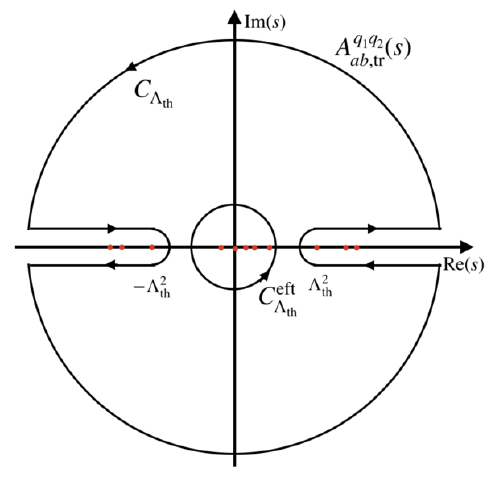
Figure 3 . Tree level dispersion relation contour in the forward